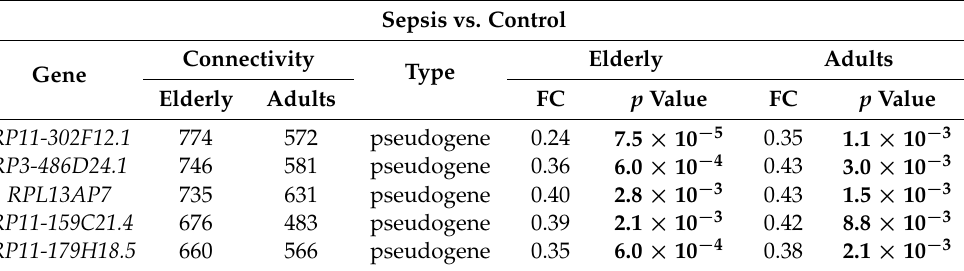
Table 2. Selected long noncoding RNAs (lncRNAs) among the most connected (top 15%) DEGs in co-expression networks from both elderly and adult subjects that show an average local similarity greater than the median similarity of enriched pathways related to protein translation. All these five lncRNAs are transcribed from ribosomal protein pseudogenes. The average fold-changes (FCs) between sepsis and control subjects for each age group are shown. Significant p values are in bold.